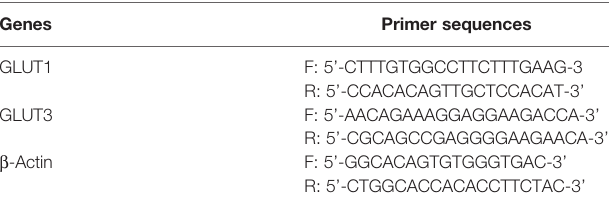
TABLE 1 | Primer sequences for RT-PCR